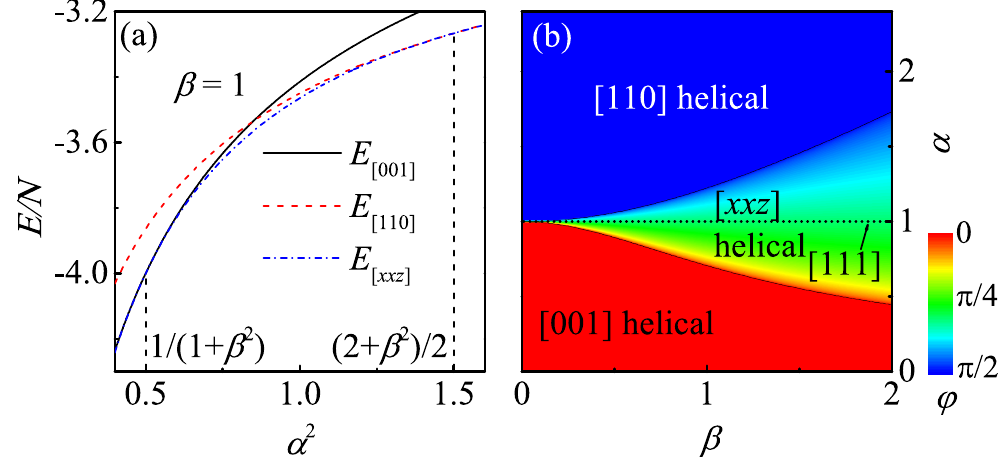
Figure 1. ( a ) The local energies as a function of α . ( b ) The ground-state phase diagram in the space of ( α , β